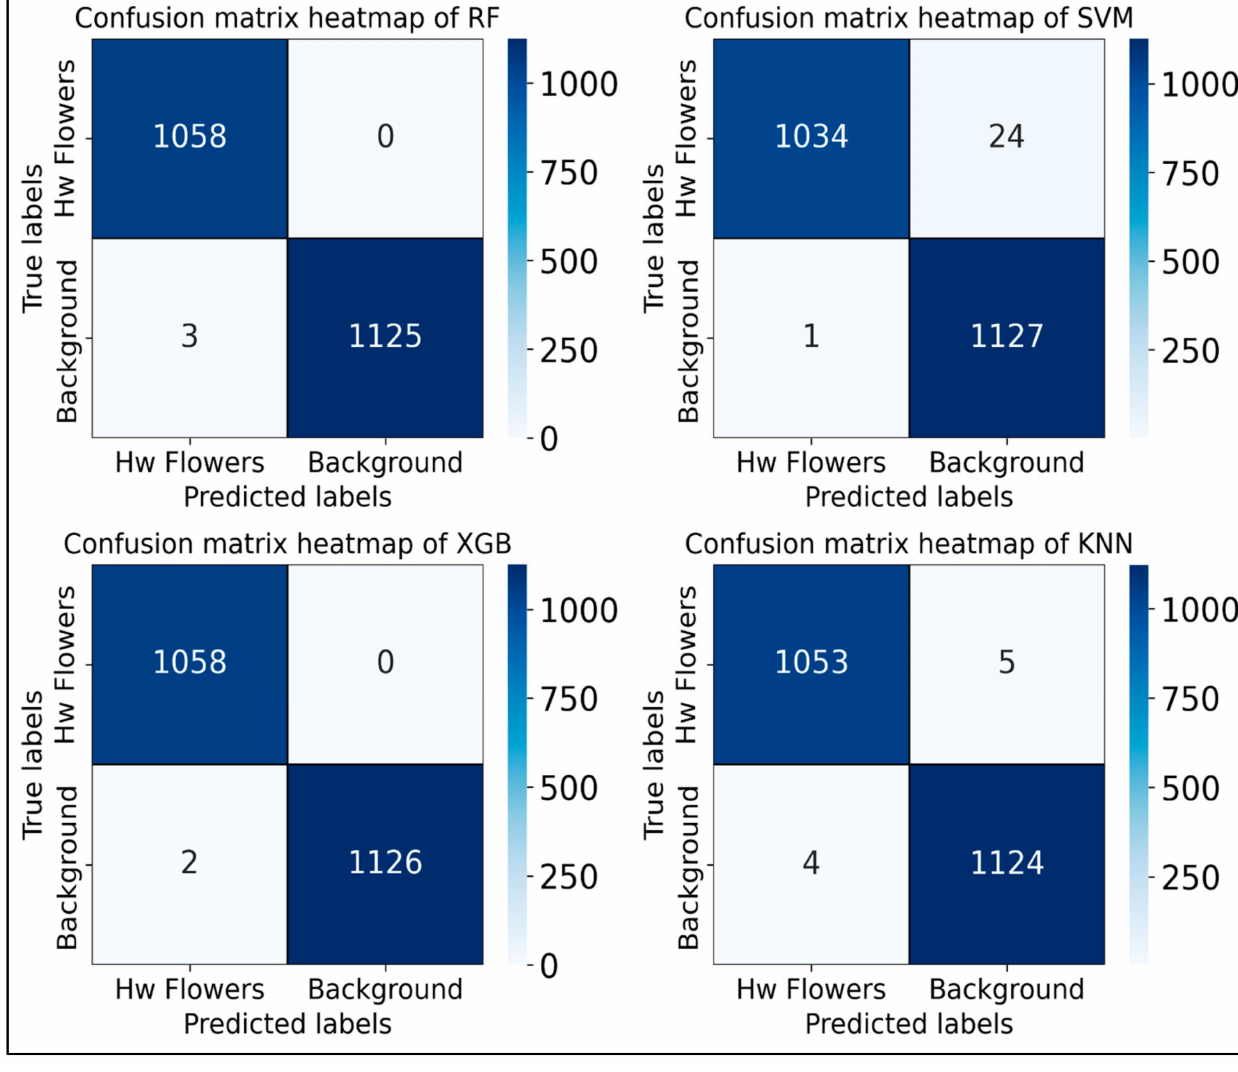
Figure 7. Confusion matrix for training of different machine learning models for flower detection. Table 6. Overall testing accuracy report of XGB for different spatial resolutions at the study site. Flight